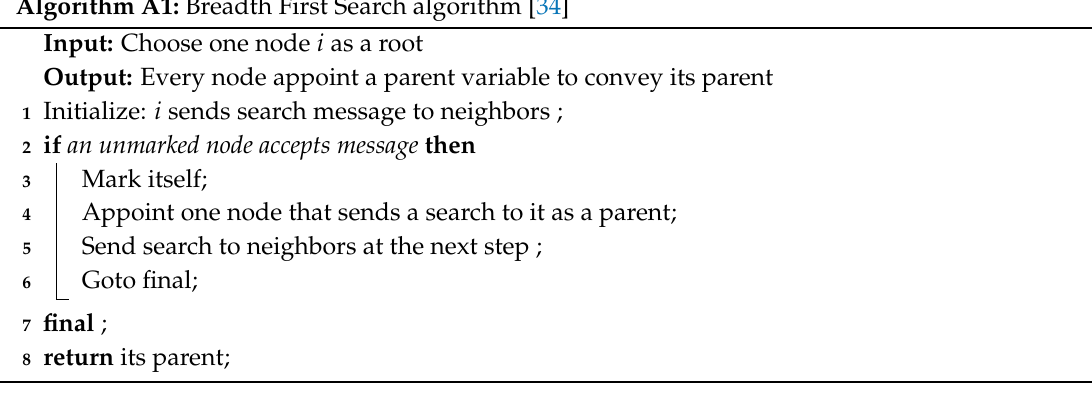
Algorithm A1: Breadth First Search algorithm [34]